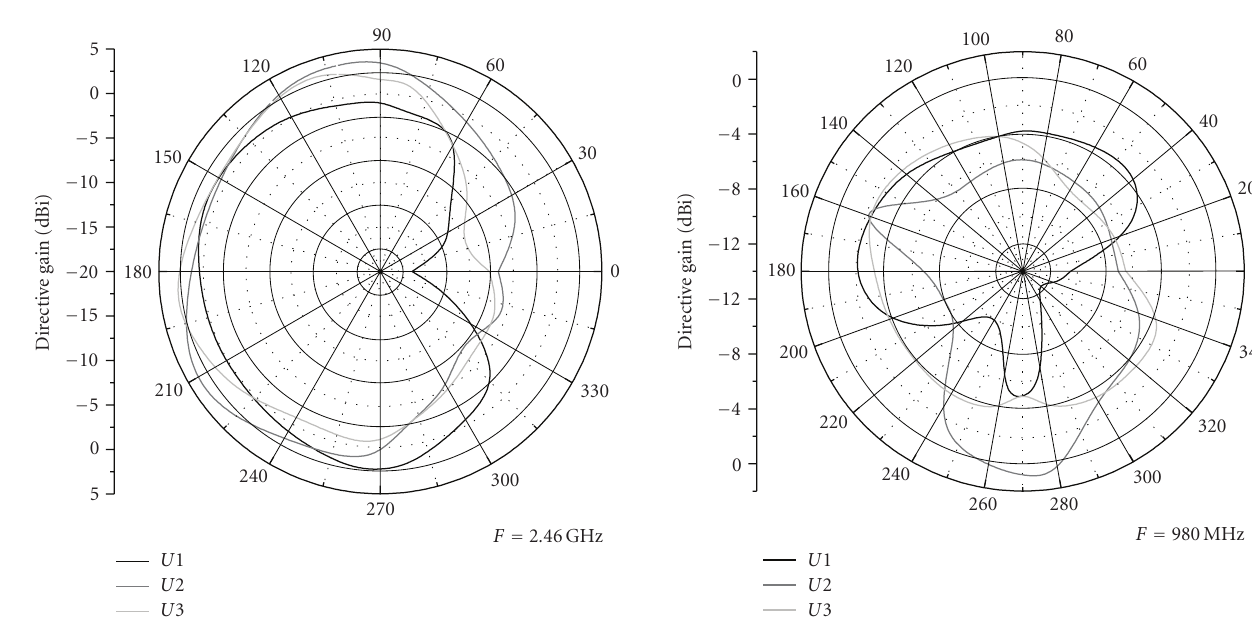
PIN polarization from U 1 to U 3. The main radiative direc- tion remains unchanged at 135 ◦ (45 ◦ to the OY